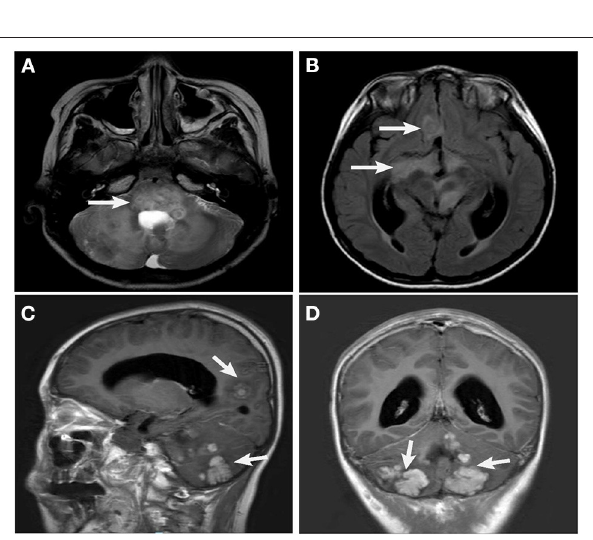
FIGURE 3 | Head MRI (case 10): Brainstem (A) , optic pathway, sellar region, anterior middle cranial fossa (B) and cerebellum (C,D) , multiple space occupying lesions with slightly longer T2 signal, high signal intensity on FLAIR image, and uneven signal intensity of the